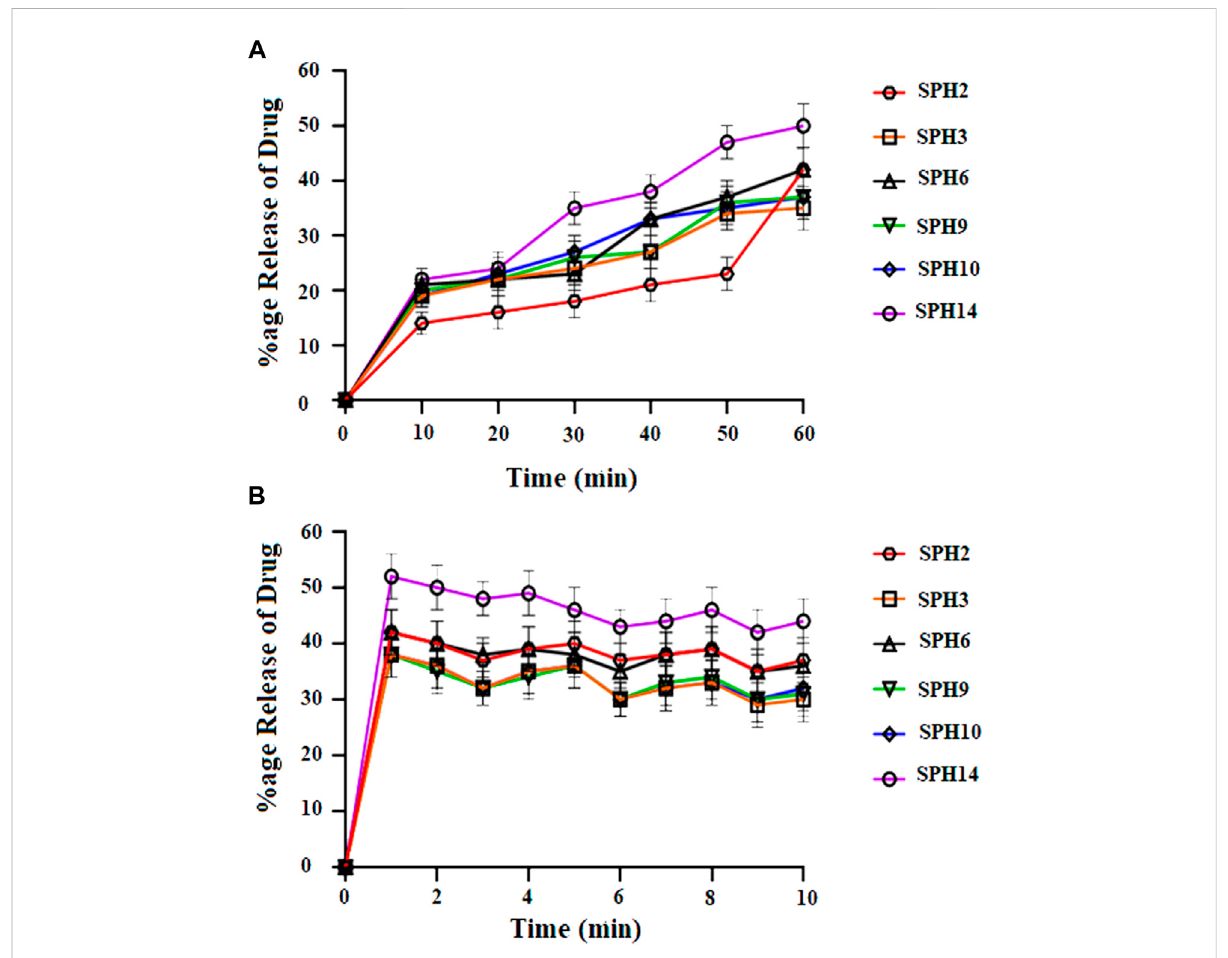
FIGURE 4 CumulativePercentreleaseofMefenamicacidfromtheSuperporousHydrogelsformulations(SPH2, SPH3,SPH6,SPH 9,SPH10,andSPH 14) in O.1 NHCL (A) and in phosphate buffer-pH 6.8 (B) n =